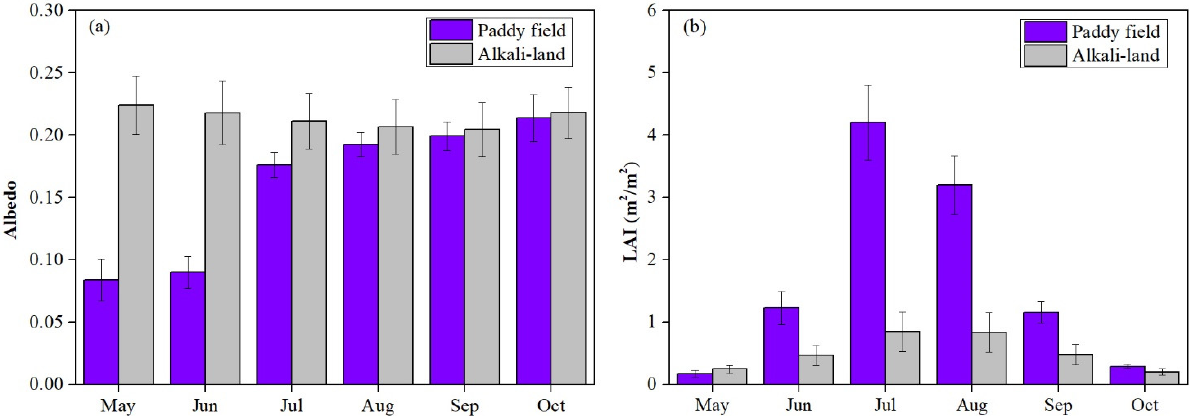
Figure 5. Spatial distribution of albedo ( a ) and LAI ( b ) for the growing season (June to September) across western Jilin.